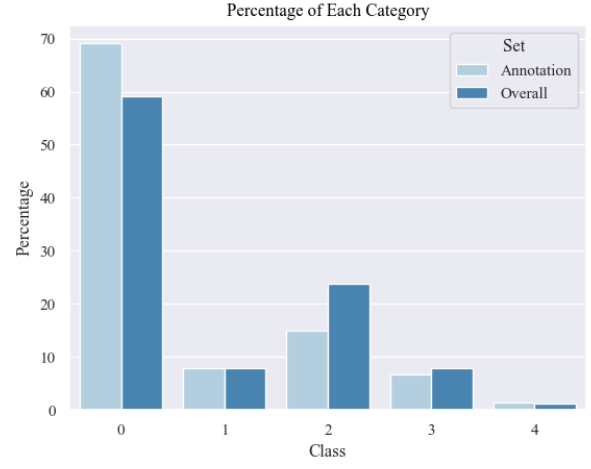
Figure 4. The distribution of five categories in different datasets.